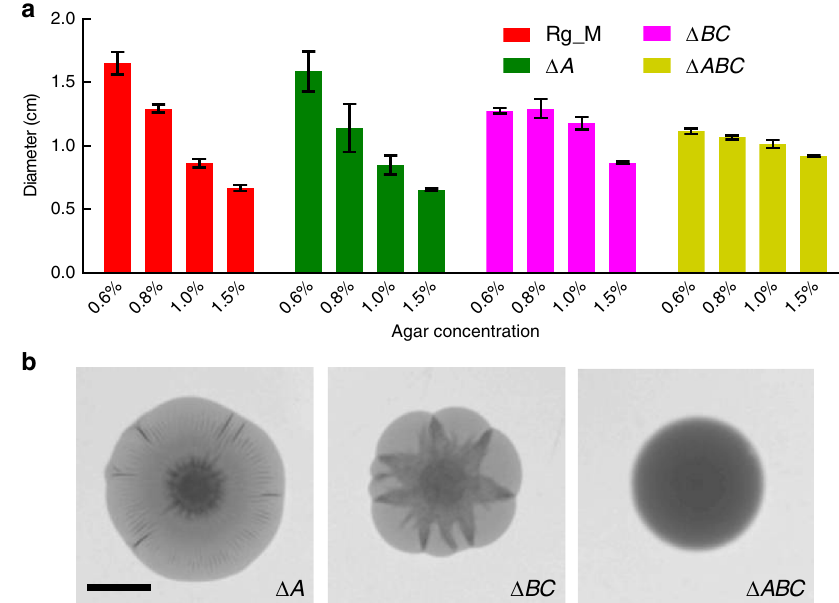
Fig. 3 Matrix proteins modulate osmotic-pressure-driven expansion of V. cholerae colony bio fi lms. a Colony bio fi lm diameter as a function of agar concentration for the Rg_M ( red ), Δ rbmA (denoted Δ A , green ), Δ bap1 Δ rbmC (denoted Δ BC , magenta ), and the Δ rbmA Δ bap1 Δ rbmC (denoted Δ ABC , yellow ) strains grown for 2 days on LB medium containing the speci fi ed concentrations of agar. b Representative images of 2-day-old colony bio fi lms of the speci fi ed mutants on LB medium containing 0.6% agar. Scale bar : 0.5 cm. All error bars correspond to standard deviations with n =